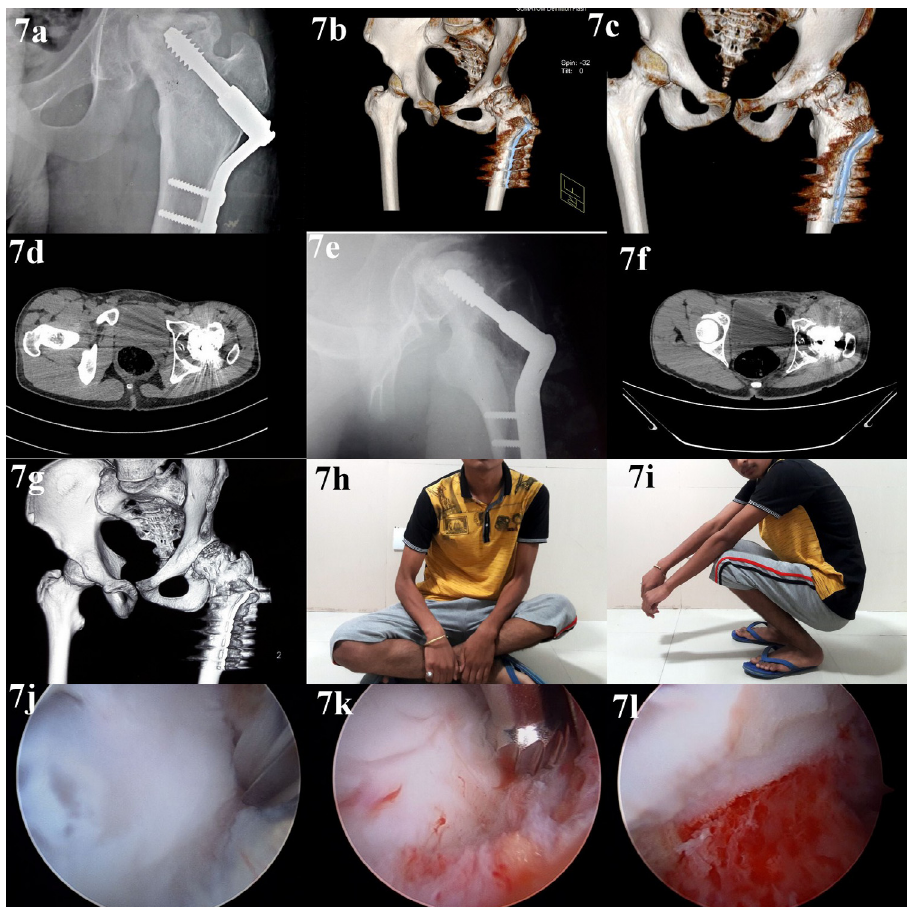
screws. The fracture failed to unite at 6 months and valgus osteotomy of proximal femur with internal fi xation with a double-angle dynamic hip screw was carried out. The fracture united and patient was asymptomatic for 1 year. Subsequently, he presented with hip pain and radiograph showed collapse of femoral head indicating ONFH. He was managed conservatively for 1.5 years. He then developed symptoms of hip impingement, with restriction of hip fl exion and rotations. There was no pain on weight bearing or walking. He was managed with arthroscopic osteochondroplasty: panel a: preoperative radiograph showing cam deformity in right femoral head; panels b – d: preoperative CT scan showing extent and location of cam deformity in the femoral head; panel e: post-operative radiograph showing restoration of femoral head sphericity; panels f and g: post-operative CT scan after removal of cam deformity; panels h and i: post-operative follow-up images showing restoration of hip range of motion; panel j: intraoperative image of hip arthroscopy showing identi fi cation of the cam deformity; panel k: intraoperative image of hip arthroscopy showing resection of the